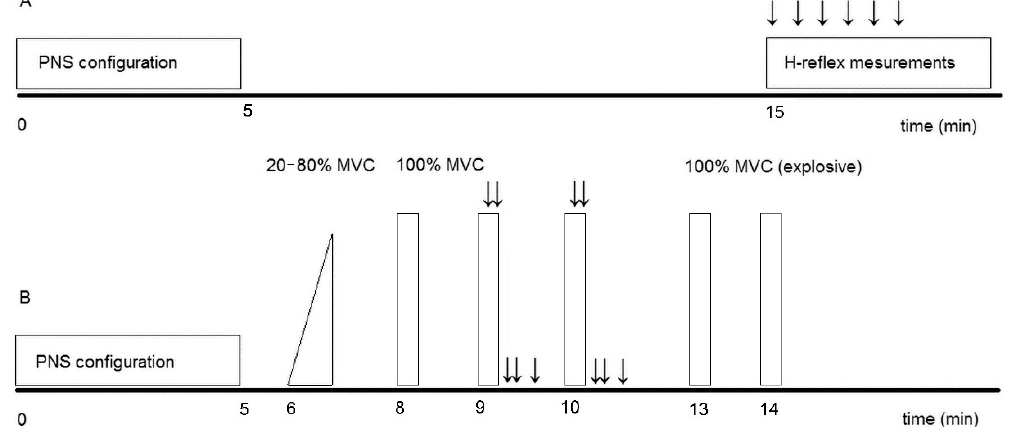
Figure 1. Overview of the neuromuscular testing protocol (panel ( A )-H-reflex, panel ( B )–maximal and explosive isometric knee extensions). Black arrows represent peripheral (tibial (A) and femoral (B) nerve stimulations; ↓↓ , double supramaximal electrical stimulation (10 ms interspersed interval); ↓ , single supramaximal electrical stimulation; MVC, maximal voluntary knee extension; PNS, peripheral nerve stimulation.